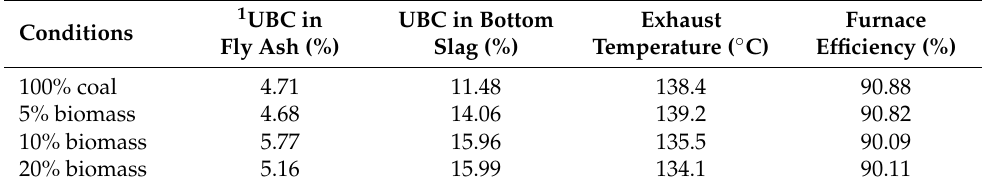
Table 6. Effects of biomass co-firing on boiler efficiency.